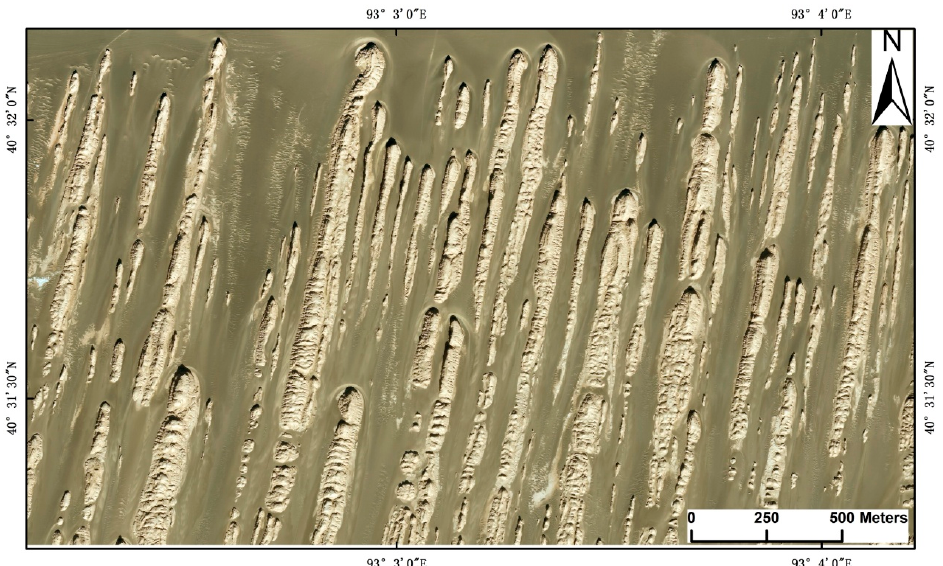
Figure 1. The original very high-resolution image subset fromGoogle Earth (displayed in true color) of the study